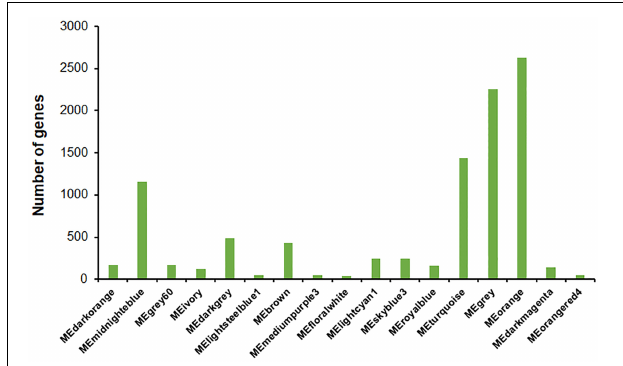
FIGURE 8 | Gene numbers in each module. Number of genes contained in each module were generated using the Dynamic Tree Cut method and setting module dissimilarity coefficients of ≤ 0.25 as a threshold for module